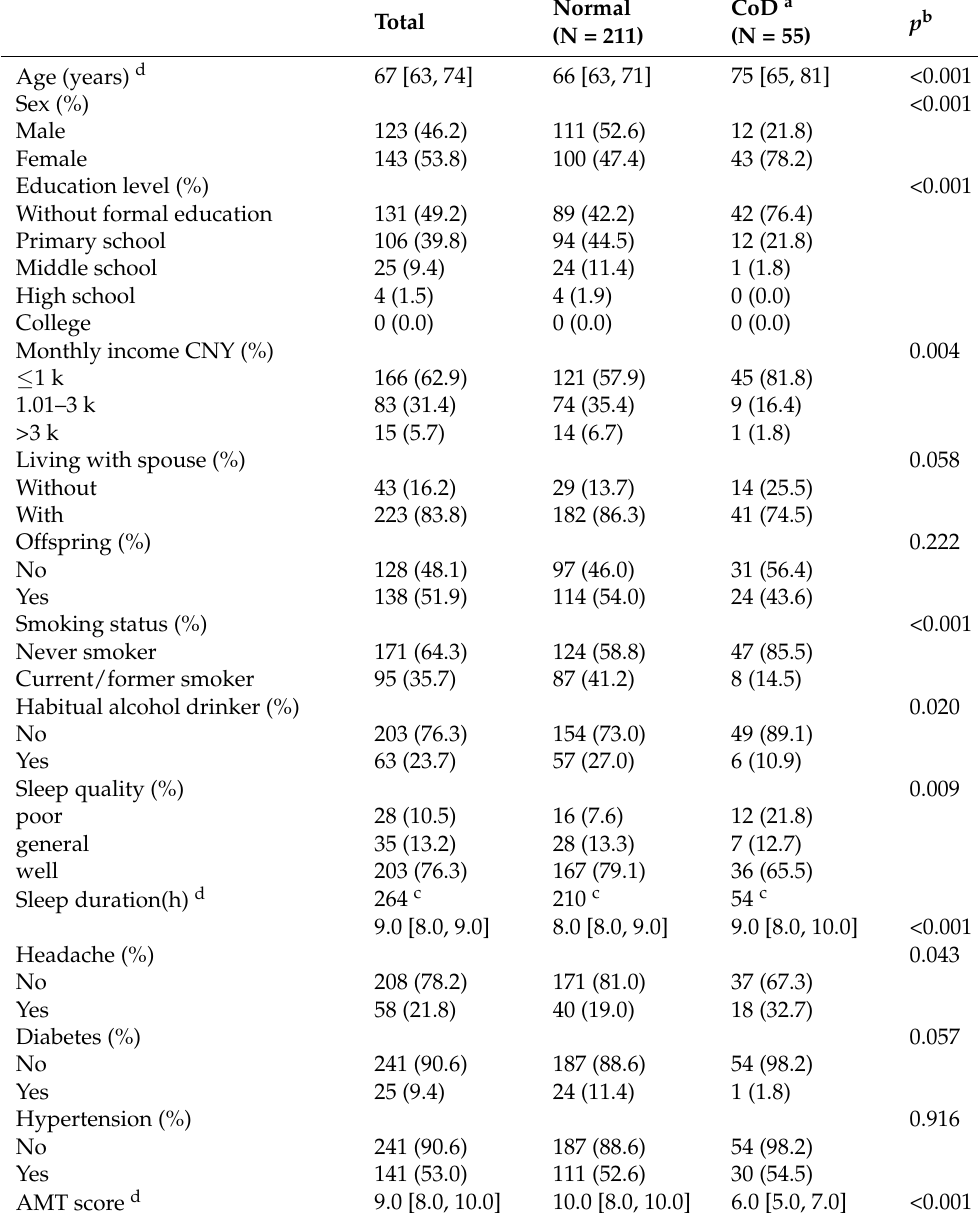
Table 1. Participants characteristics (N =